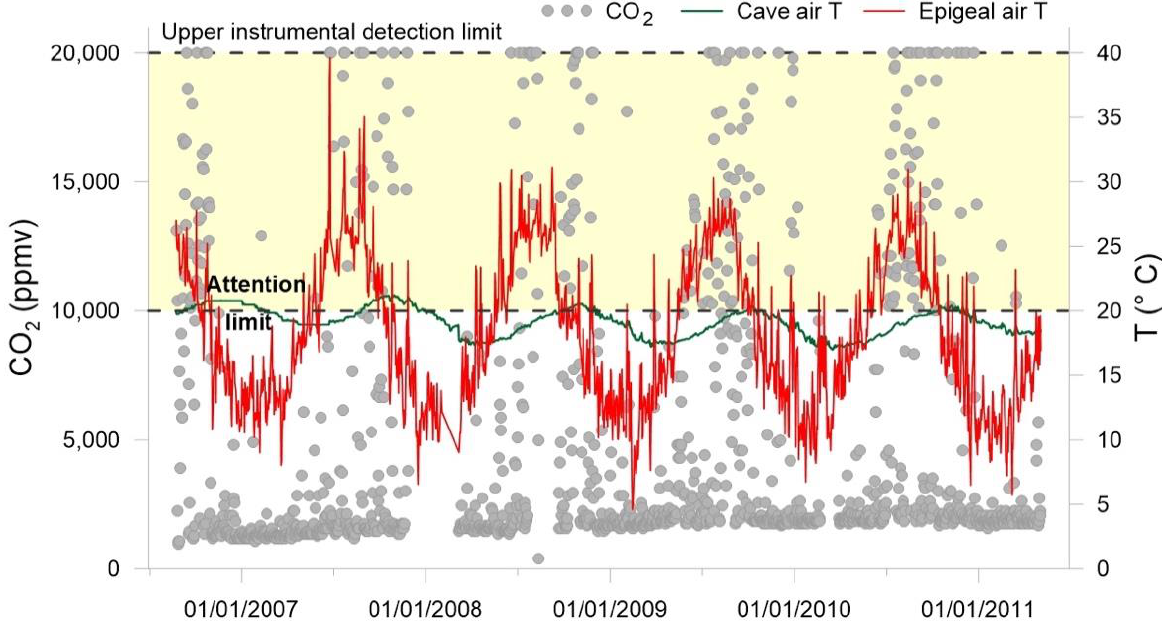
Figure 7. Near-real-time data of air temperature (daily average, green line) and CO 2 concentrations (grey points, 1 acquisition per day) acquired inside Carburangeli cave between 2006 and 2011; daily average epigeal air temperatures (red line) are reported for comparison. See Discussion for the definition of attention limit line.